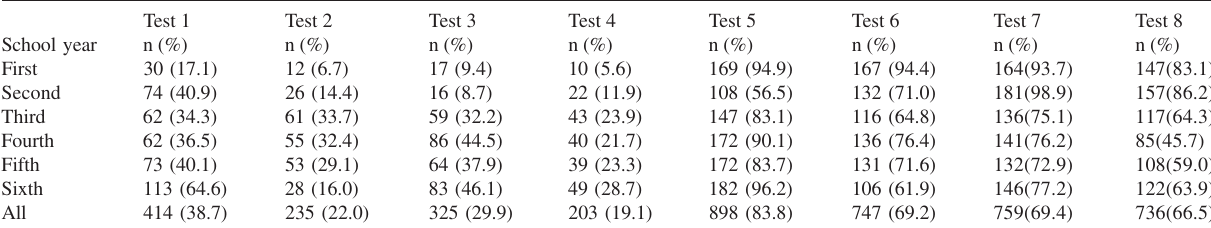
Table 1 - Student attendance in the 8 applications of progress testing, according to school year